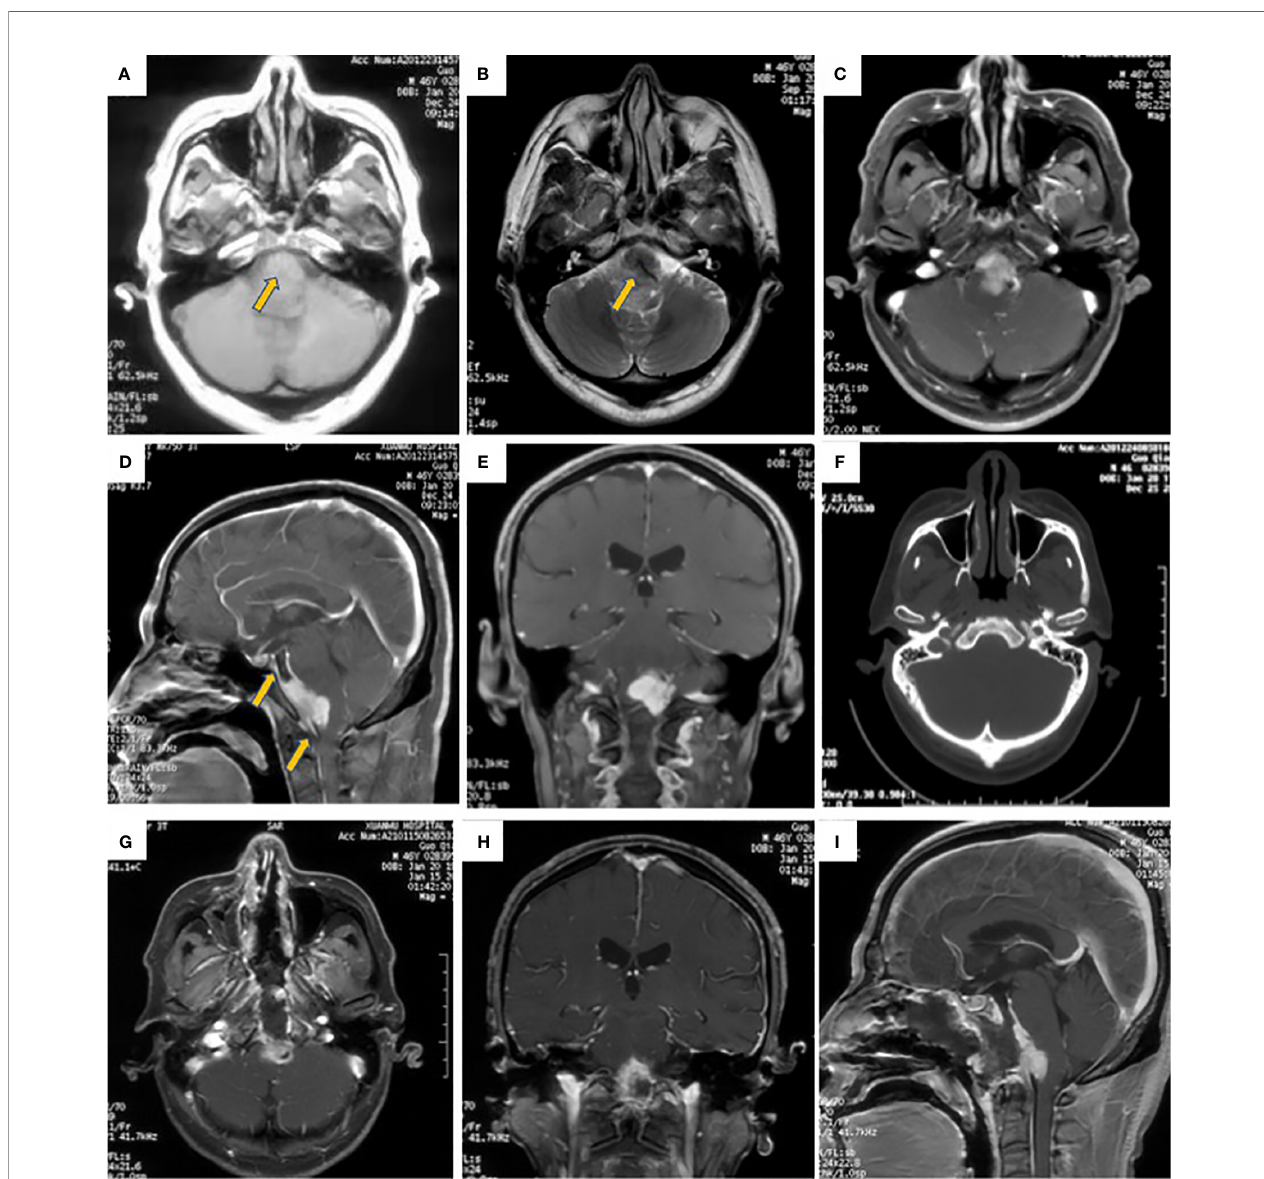
FIGURE 1 | Brain MRI images showed intracranial mass located at middle of upper clivus region. (A, B) . The lesion located at middle of upper clivus region presented with isointense signal in T1-weighted MRI image ( A , the arrow), and hypointense signal in T2-weighted MRI image ( B , the arrow); (C, E) : The mass was uniformly enhanced after contrast MRI scan, and the base of the tumor was extensively stick to the adjacent dura and brain stem, showing meningeal tail sign (the arrow in D ), and meningioma was highly suspected. (F) . CT bone window showed no bone invasion. (G, I) . The MRI showed partial resection of the